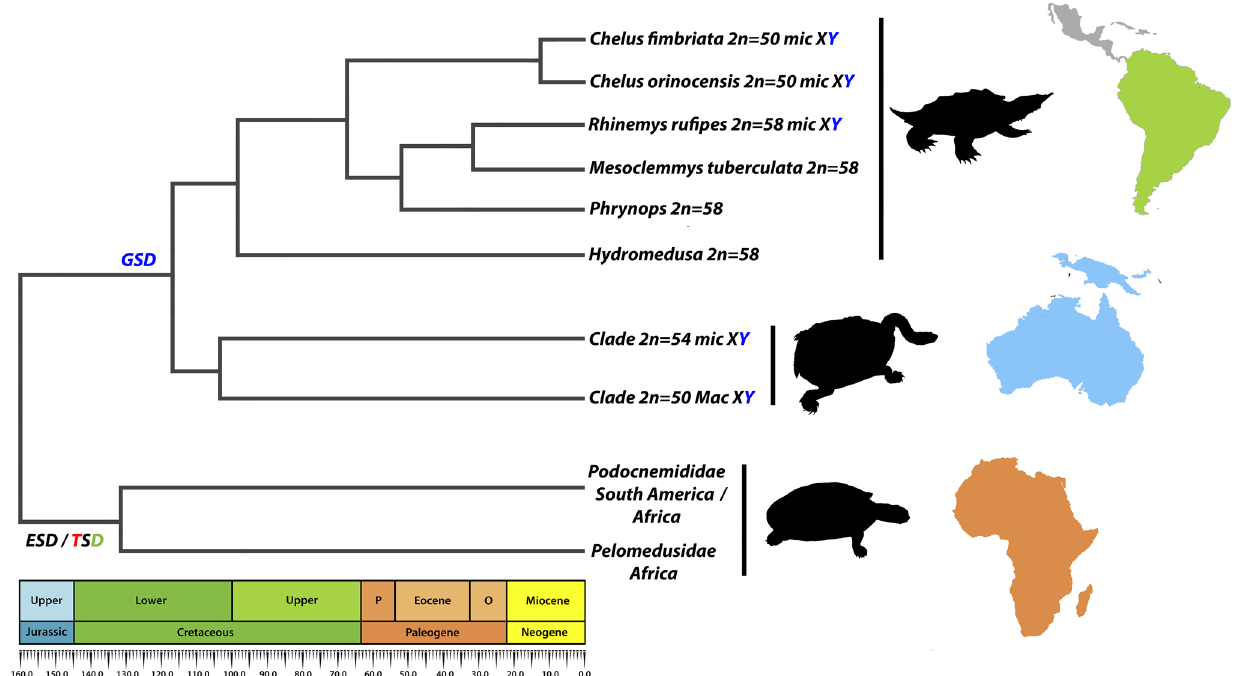
Figure 10. Chronogram for some chelid species and their modes of sex determination, adapted from 6,21 . P = Paleocene and O =